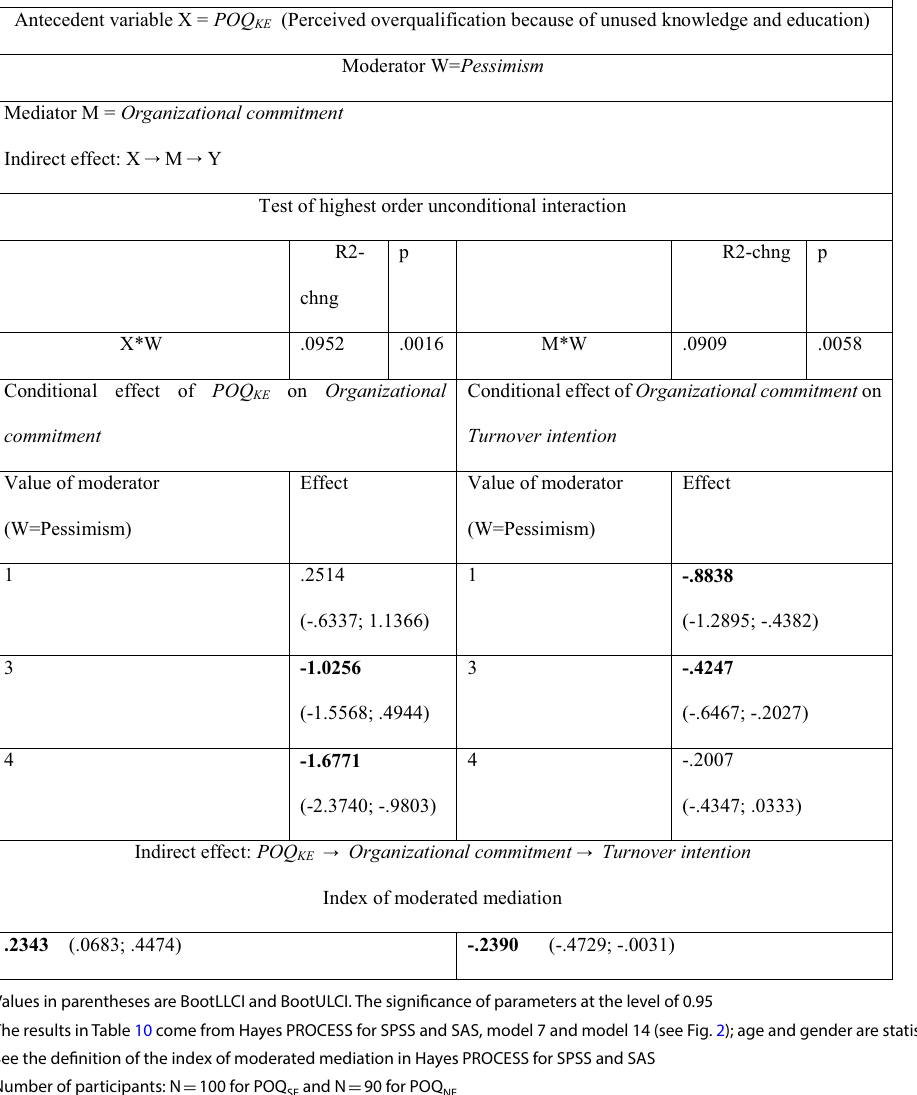
(Perceived overqualification because of unused knowledge and education, POQ KE